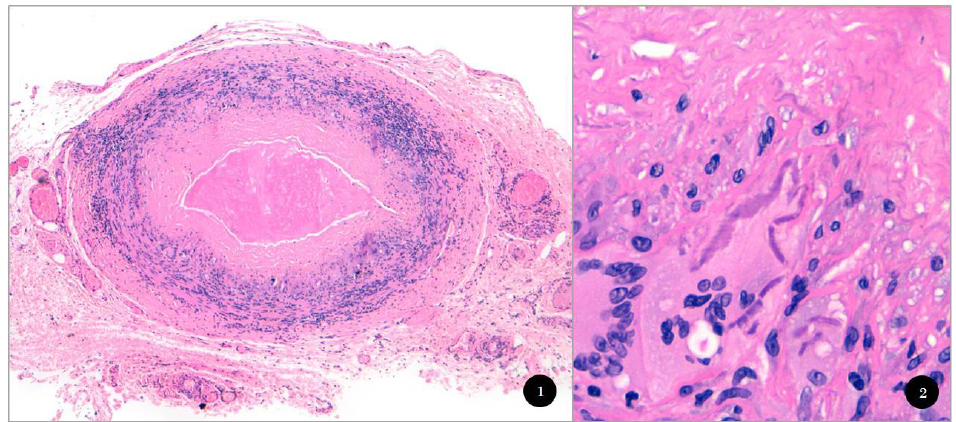
FIGURE 2. (1) Temporal artery cross-section (H&E; magnification  40). (2) Giant